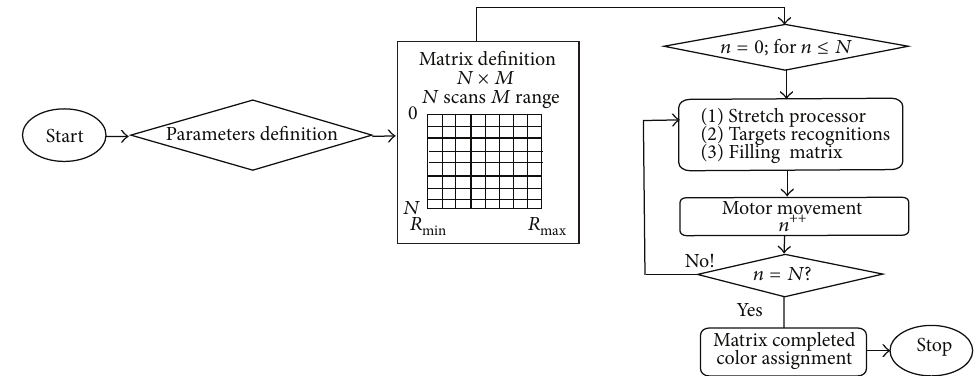
Figure 5: Block diagram of the scanning SDRadar algorithm.